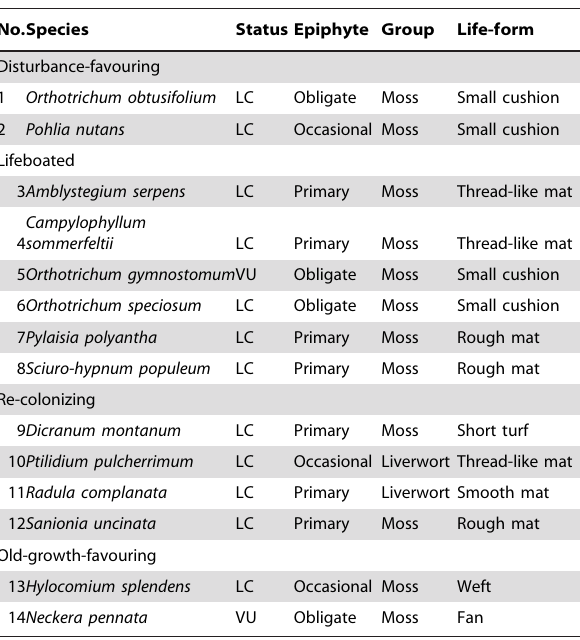
Table 2. Examples of species in the four reaction groups (disturbance-favouring, lifeboated, re-colonizing, old-growth favouring; the classification is based on the presence-absence